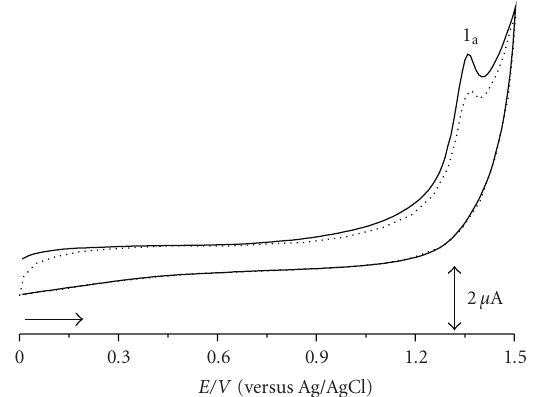
Figure 1: Cyclic voltammograms of 100 μ M FLU in pH 6.1 0.1 M phosphate bu ff er solution, N 2 saturated; “solid line” first scan, “dotted line” second scan, and ν = 100 mV s − 1